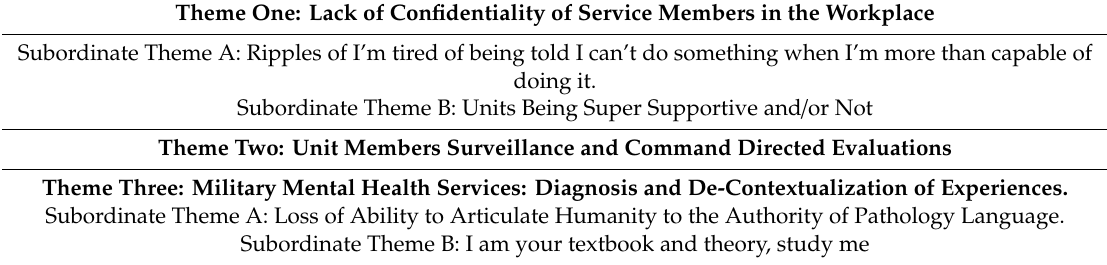
Table 1. Themes and Subordinate